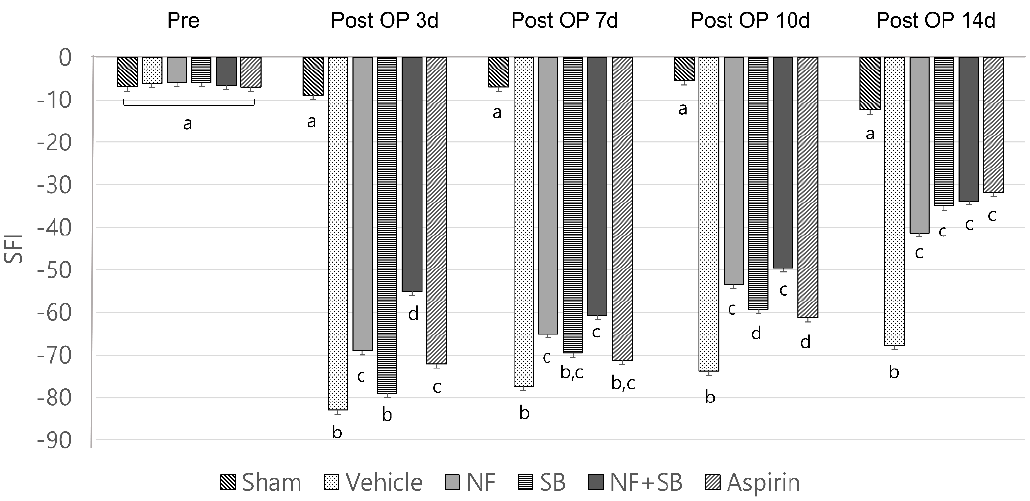
Figure 2. Effect of NF on walking track test at 3rd, 7th, 10th, and 14th day after crush nerve injury. The NF treated group showed recovery of gait function. Levels of SFI (sciatic function index) were measured based on the footprints on the walking track. Data are expressed as mean SFI ± SD. Data were analyzed by ANOVA with Tukey’s post hoc analyses. Values with the different small letters (a–d) are significantly different among six treated groups of same time group at p < 0.05.